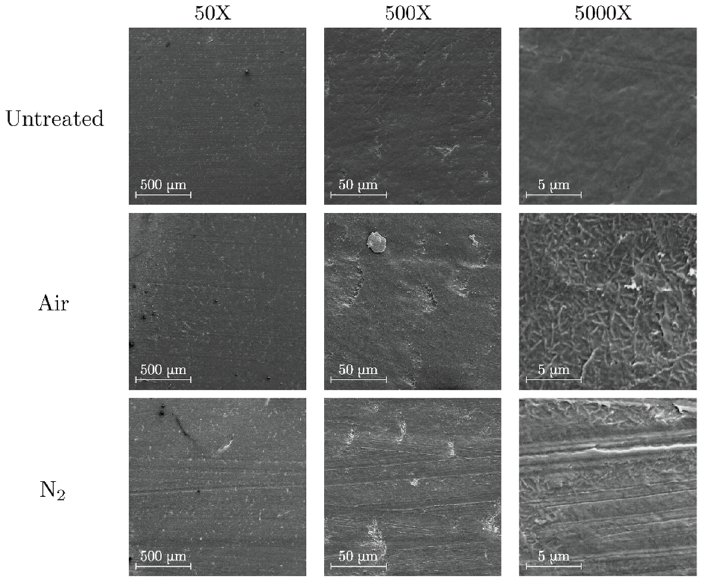
Figure 5. SEM images of untreated ( top ), air-treated ( center ), and nitrogen-treated ( bottom ) polytetrafluorethylene (PTFE).